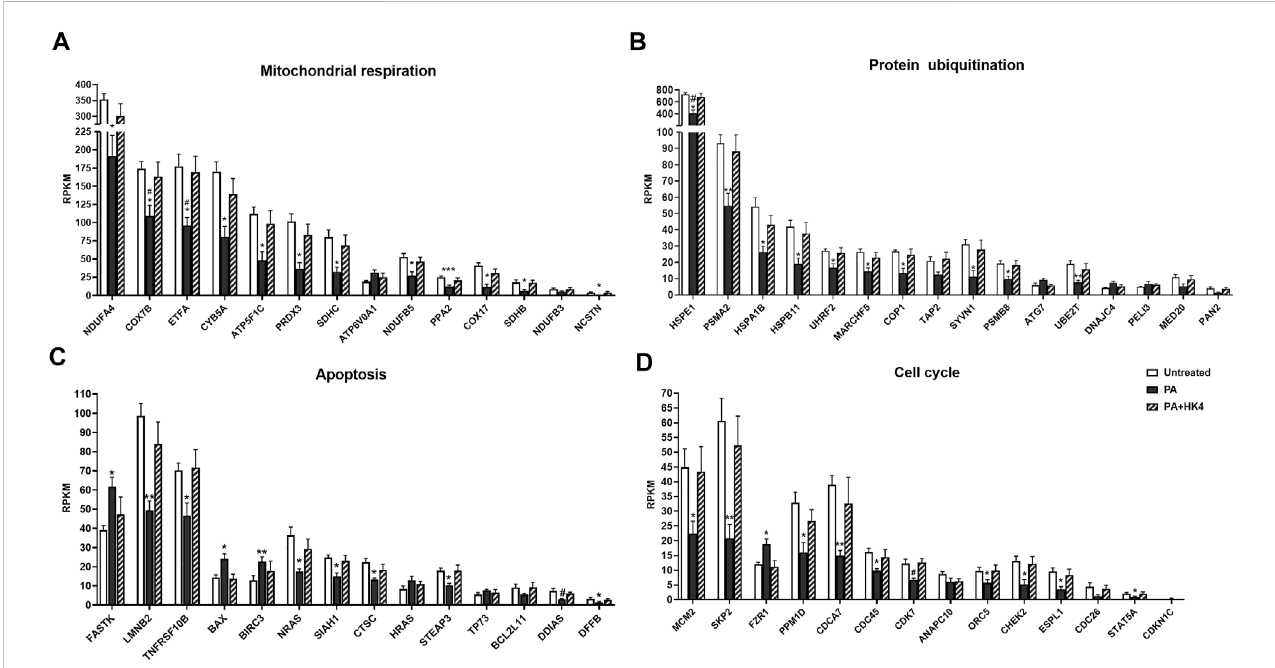
FIGURE 4 Reads per kilobase of transcript per million mapped reads (RPKM) expression values of genes related to mitochondrial respiration (A) , protein ubiquitination (B) , apoptosis (C) and cell cycle (D) . Genes were selected of the 456 DEGs among untreated (white), palmitate (PA, black) and PA + HK4 (black striped)-treated HepG2 cells and sorted by descending expression values of PA. p -values were calculated by two-way ANOVA; *** p ≤ 0.001, ** p ≤ 0.01, * p ≤ 0.05 vs. untreated, # p ≤ 0.05 vs. PA + HK4-treated cells. Abbreviations of genes are explained in Supplementary Table